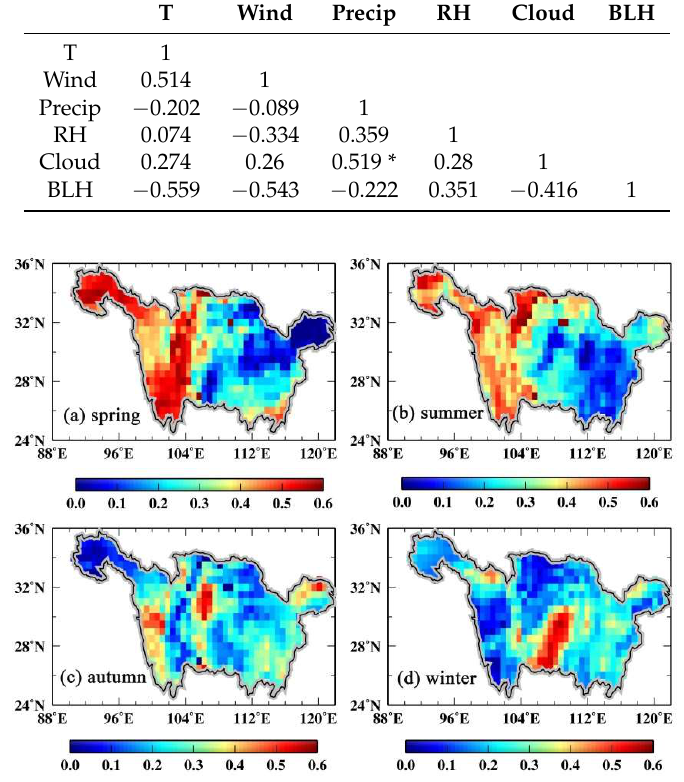
Figure A5. Coefficients of determination (R 2 ) of the MLR model between PM 2.5 and the six meteorological variables in spring (a), summer (b), autumn (c) and winter (d).